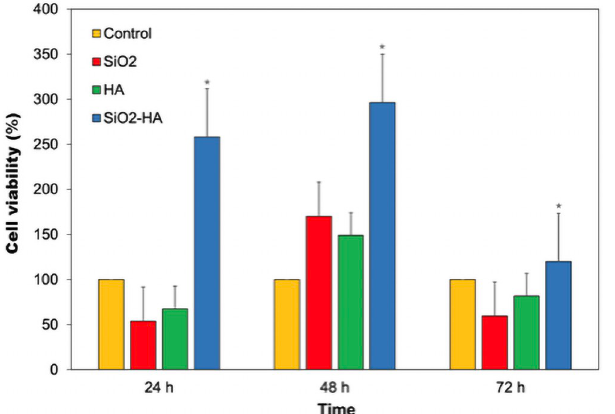
Fig 6. Cell viability of fibroblasts incubated onto thermal-treated SiO 2 , HA and SiO 2 -HA membranes at 800˚C. � means p value < 0.05.